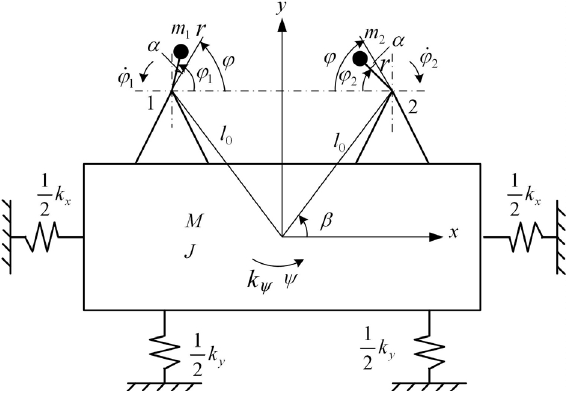
Fig. 1. Dynamic model of a vibrating system with two motors rotating in opposite directions.